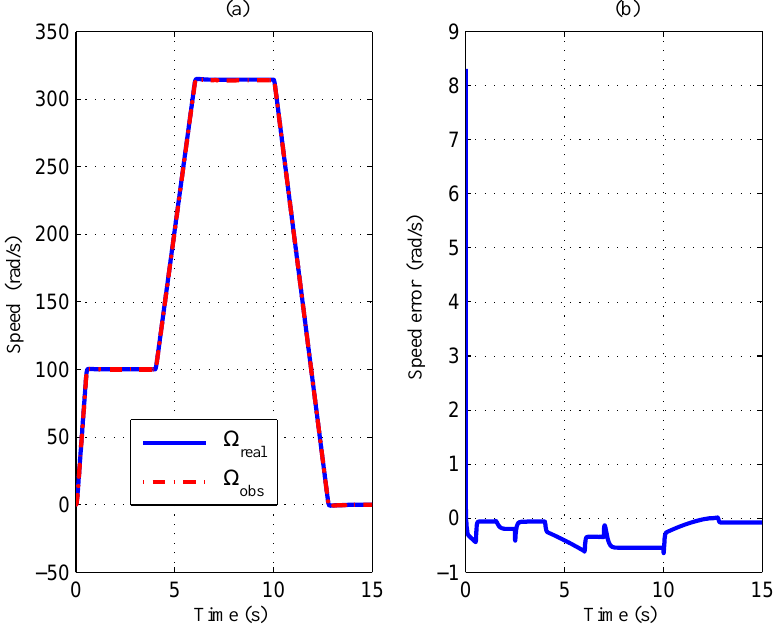
Figure 3. Tracking performance (nominal case): ( a ) observed and measured speeds; and ( b ) speed error.